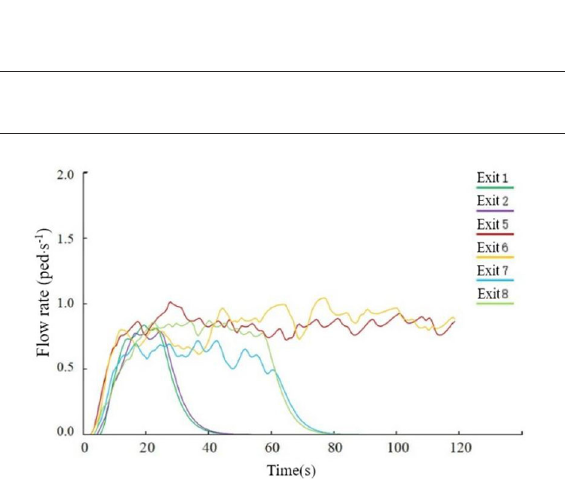
FIGURE15 The flow of each outlet when the cabin is in a horizontal